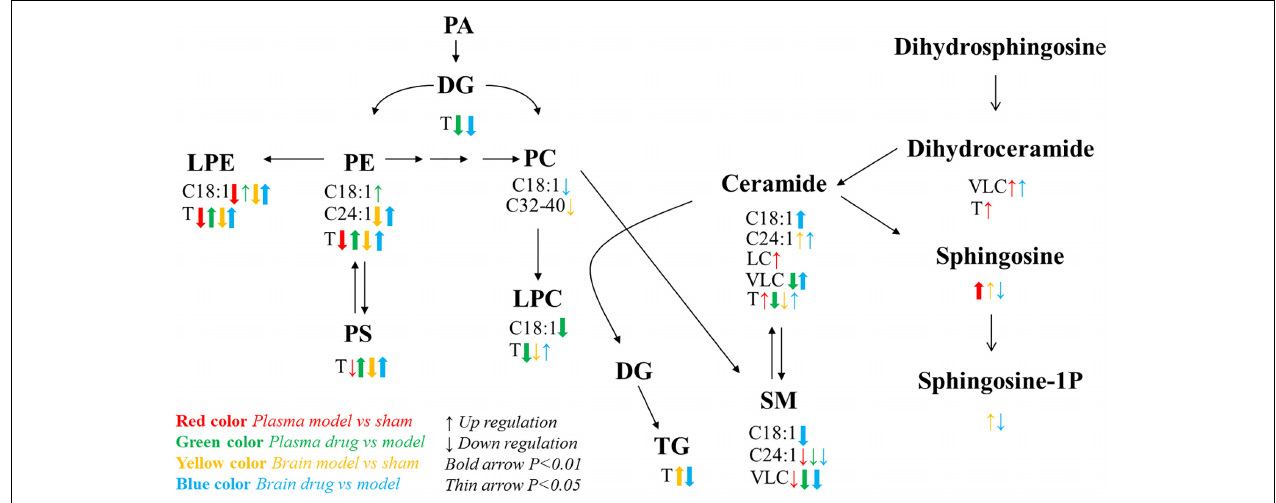
FIGURE 5 | Lipid metabolic network and the variation tendency. Red arrows represent the comparison between the sham operation and model groups with respect to plasma; green arrows represent the comparison between the dosed model and model groups; yellow arrows represent the comparison between the sham operation and model groups with respect to brain tissue; blue arrows represent the comparison between the dosed model and model groups. Up arrows indicate an increase, and down arrows indicate a decrease. C18:1 indicates lipids with an 18:1 acyl chain; C24:1 indicates lipids with a 24:1 acyl chain; LC refers to long acyl chain lipids ( ≤ 20 ◦ C); and VLC refers to very long acyl chain lipids ( ≥ 20 ◦ C). T means total